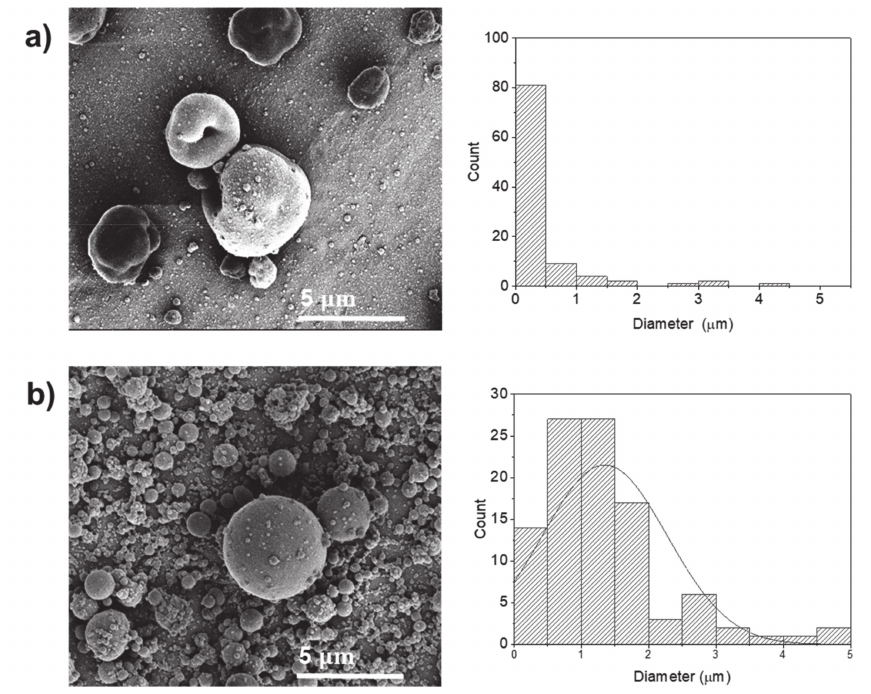
Figure 2. SEM images of electrosprayed potato protein particles, using water as a solvent, and respective histograms displaying their diameter distribution. Samples prepared using 40% w / v protein and processed at voltages of ( a ) 25 kV and ( b ) 30